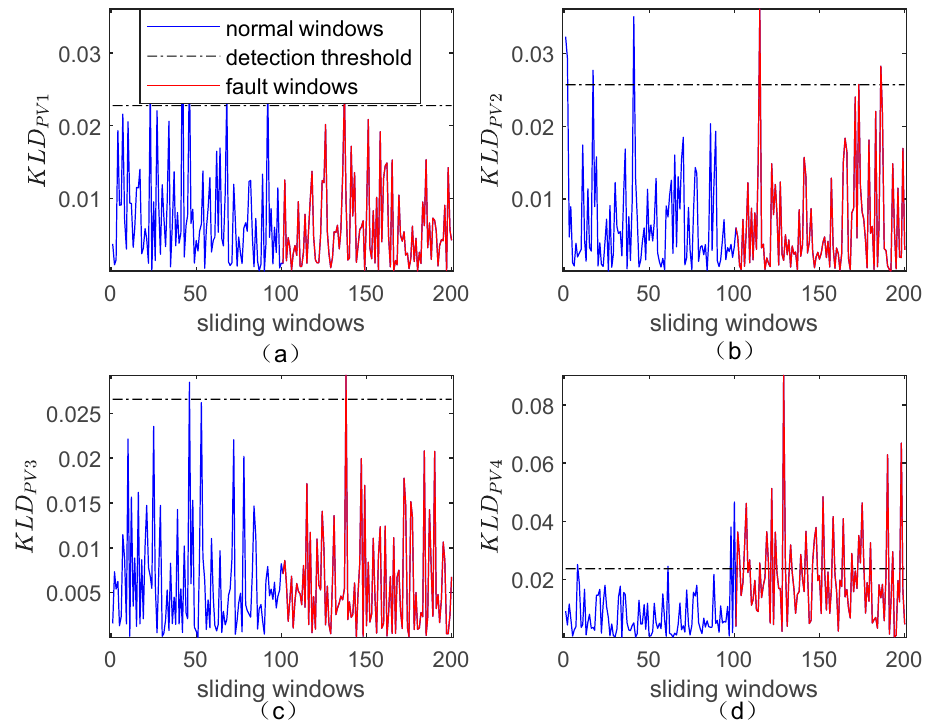
Figure 8. The results of detecting the incipient fault f 3 by using the PCA + KLD1 method and the PCA + KLD2 method: ( a ) the result of first PV for the fault f 3 ; ( b ) the result of second PV for the fault f 3 ; ( c ) the result of third PV for the fault f 3 ; ( d )